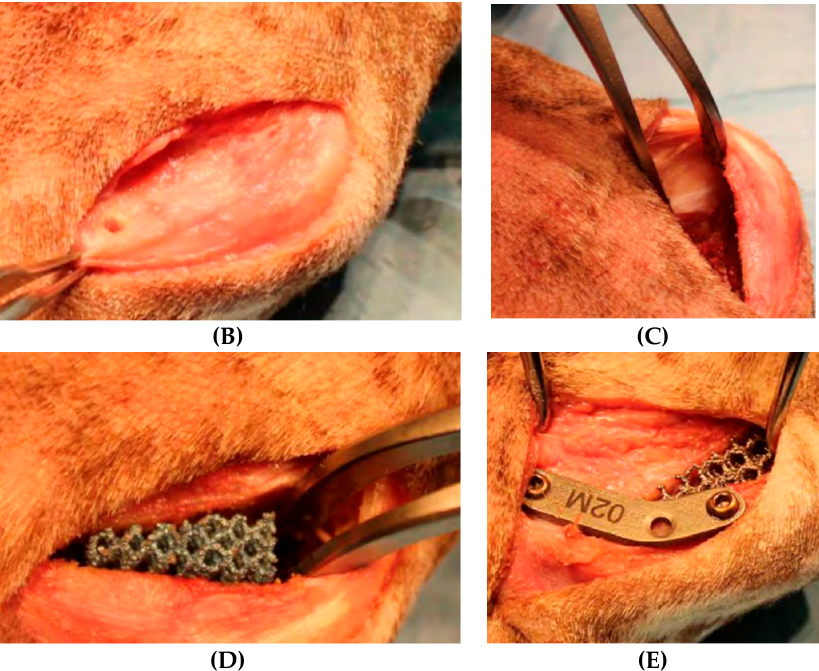
Figure 4. The surgical procedure ( A ) Osteotomy guide; ( B ) Maquet hole on the distal tibial tuberosity; ( C ) distraction of the tibial tuberosity; ( D ) porous titanium cage in the osteotomy; ( E ) plate and screws placed to fix the implant.